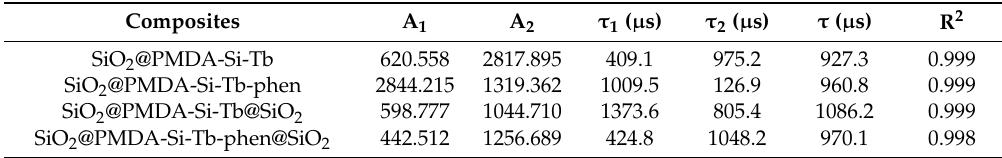
Table 2. The lifetime parameters obtained from the biexponential fitting to the photoluminescence decay values of Tb(III) core-shell and core-shell-shell